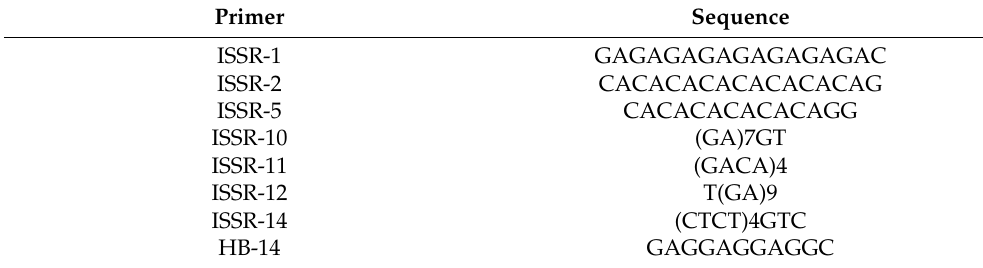
Table 7. Sequences and codes of eight ISSR